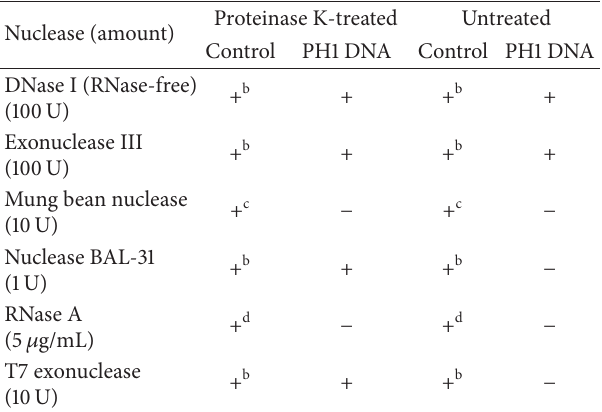
Table 3: Digestion of the PH1 genome by nucleases a